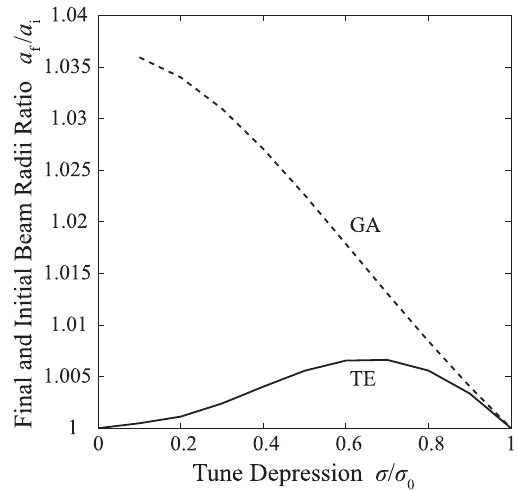
FIG. 1. Final and initial beam radii ratio as a function of tune depression for Gaussian (dashed line) and thermal equilibrium (solid curve) distributions. GA and TE imply Gaussian and thermal equilibrium distributions,